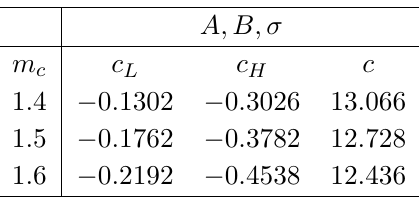
√ s = 10 . 6 GeV. The unit of m c